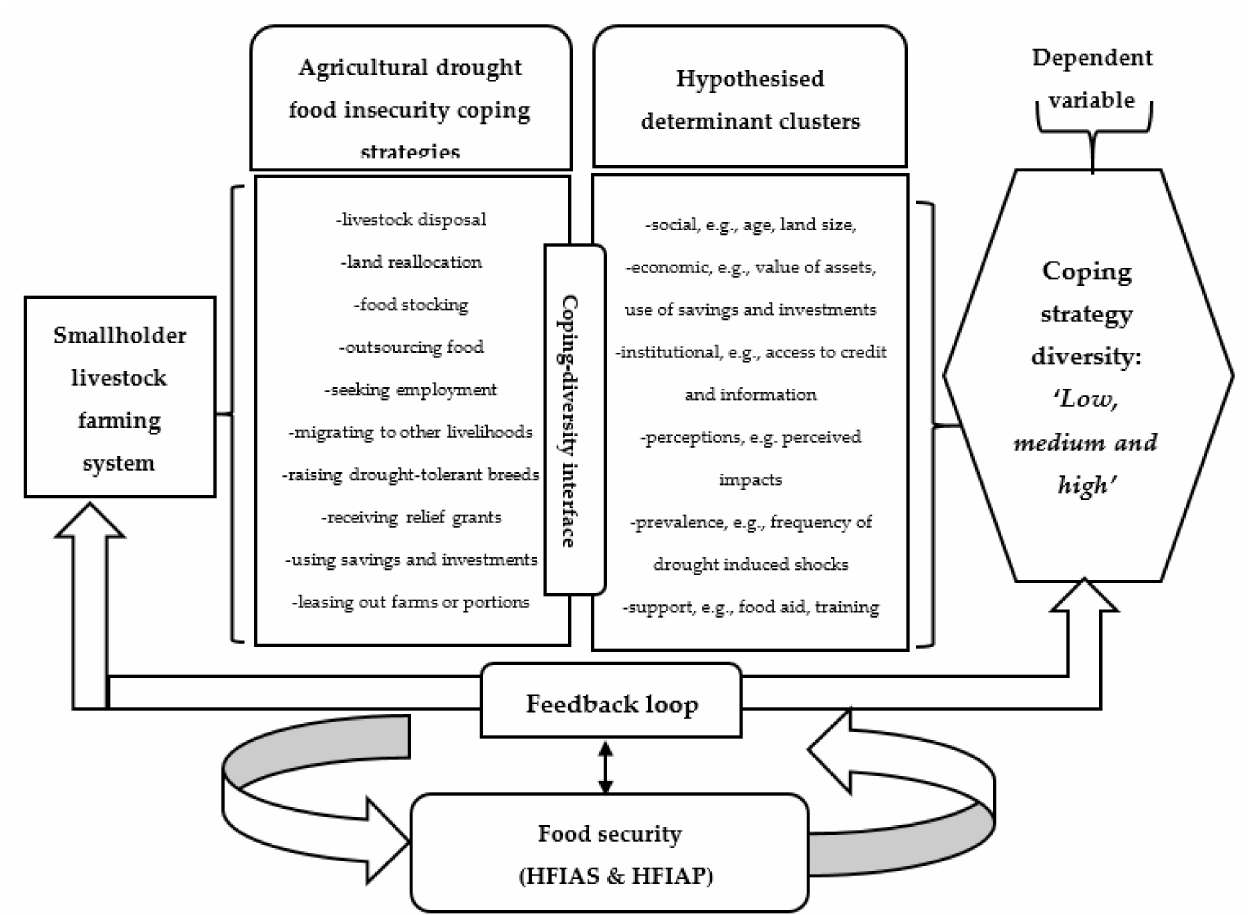
Figure 2. Conceptualizing agricultural drought-induced food insecurity coping diversity. Source: Authors’